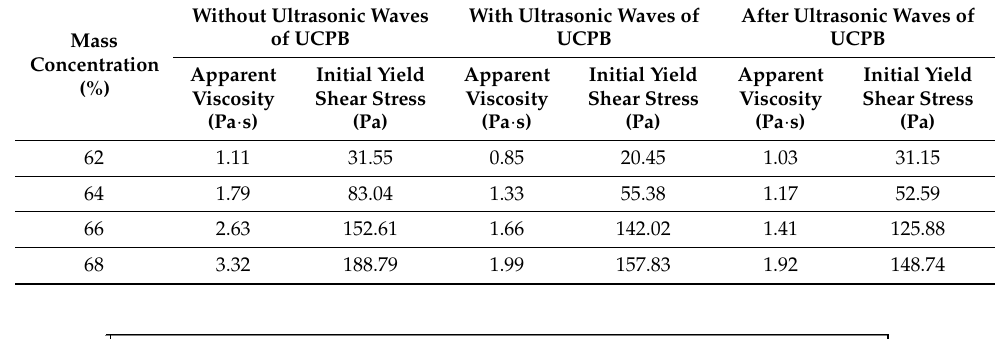
Table 7. Apparent viscosity and initial yield shear stress of filling slurry.